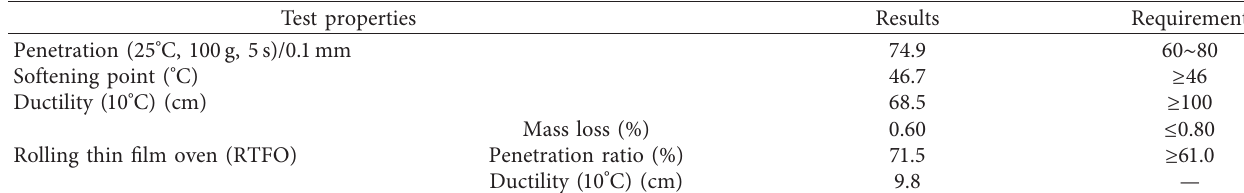
Table 1: Physical properties of base asphalt.